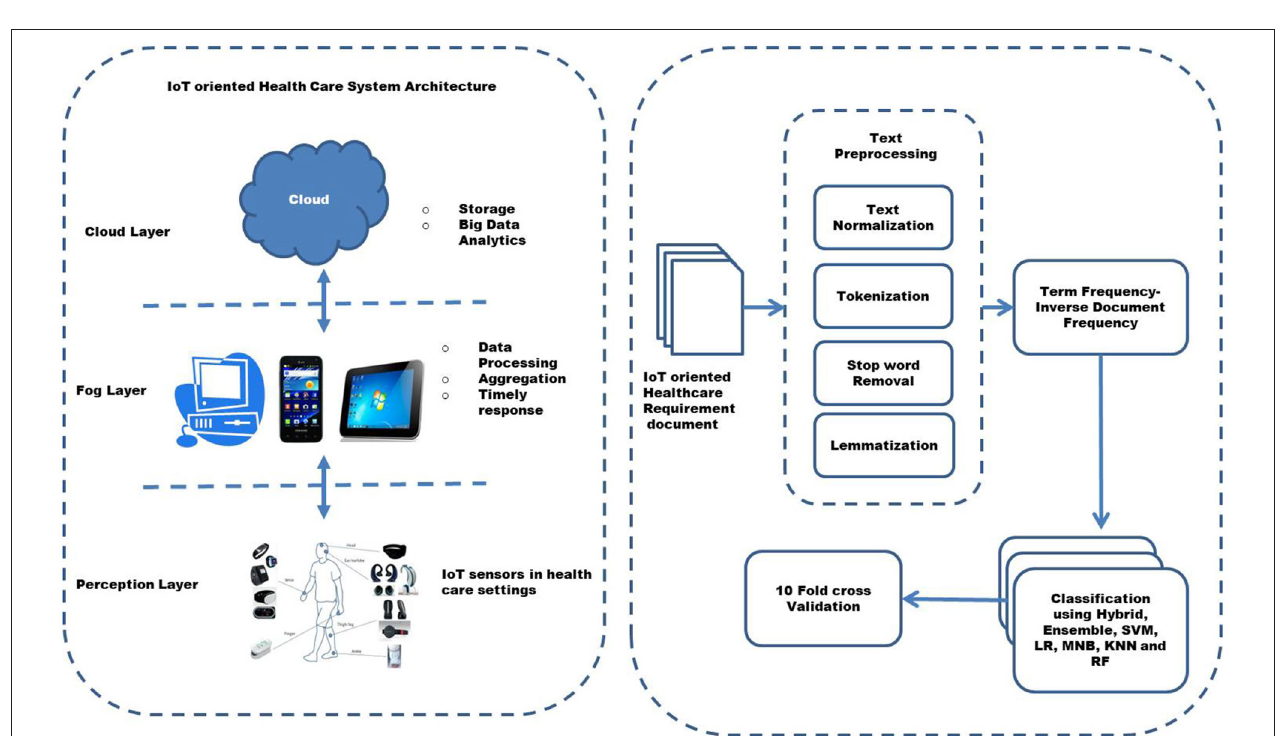
Frontiers in Public Health |